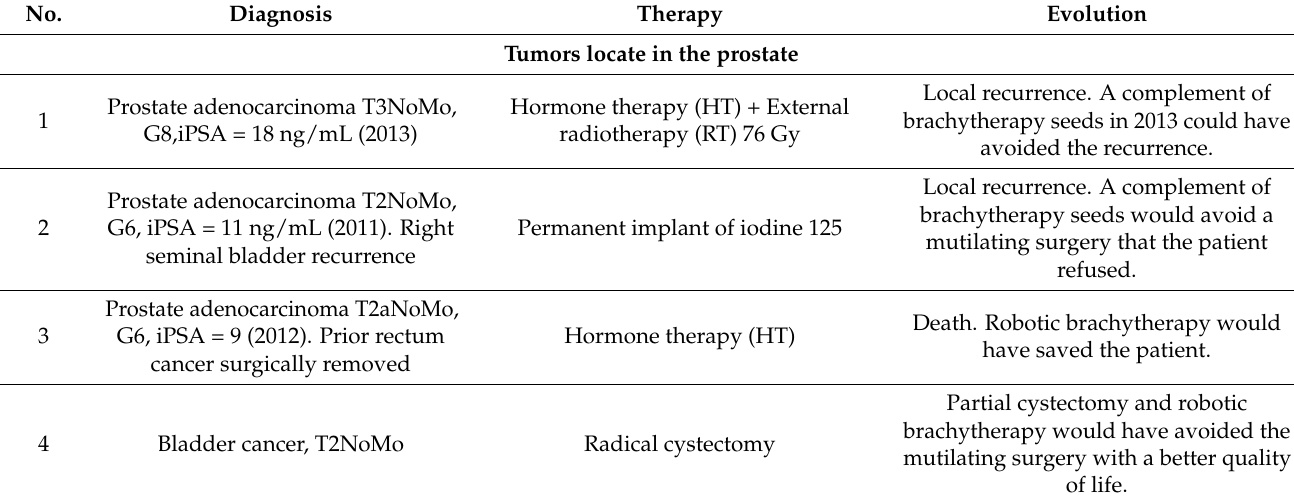
Table 2. Clinical cases which could benefit from